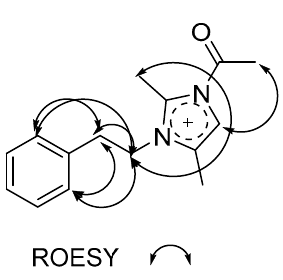
Figure 2. Key COSY (bold lines), 13 C- 1 H HMBC (single arrows), and TOCSY (bold lines) correlations for compound 1 .